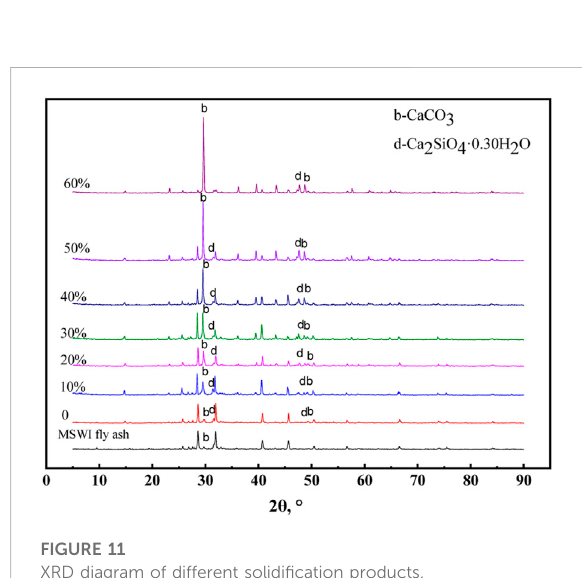
XRD diagram of different solidi fi cation